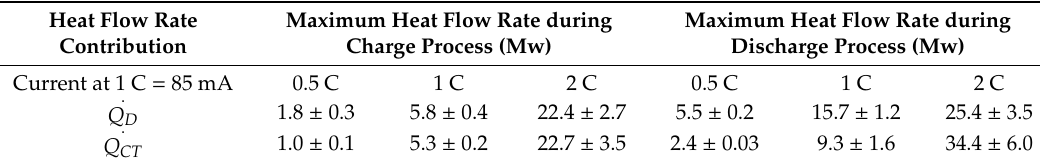
Table 1. Maximum heat flow rates due to di ff usion and charge transfer impedance for the charge and discharge process at di ff erent C rates.